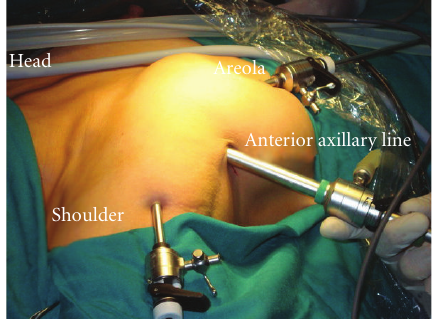
Figure 2: Axillary-breast